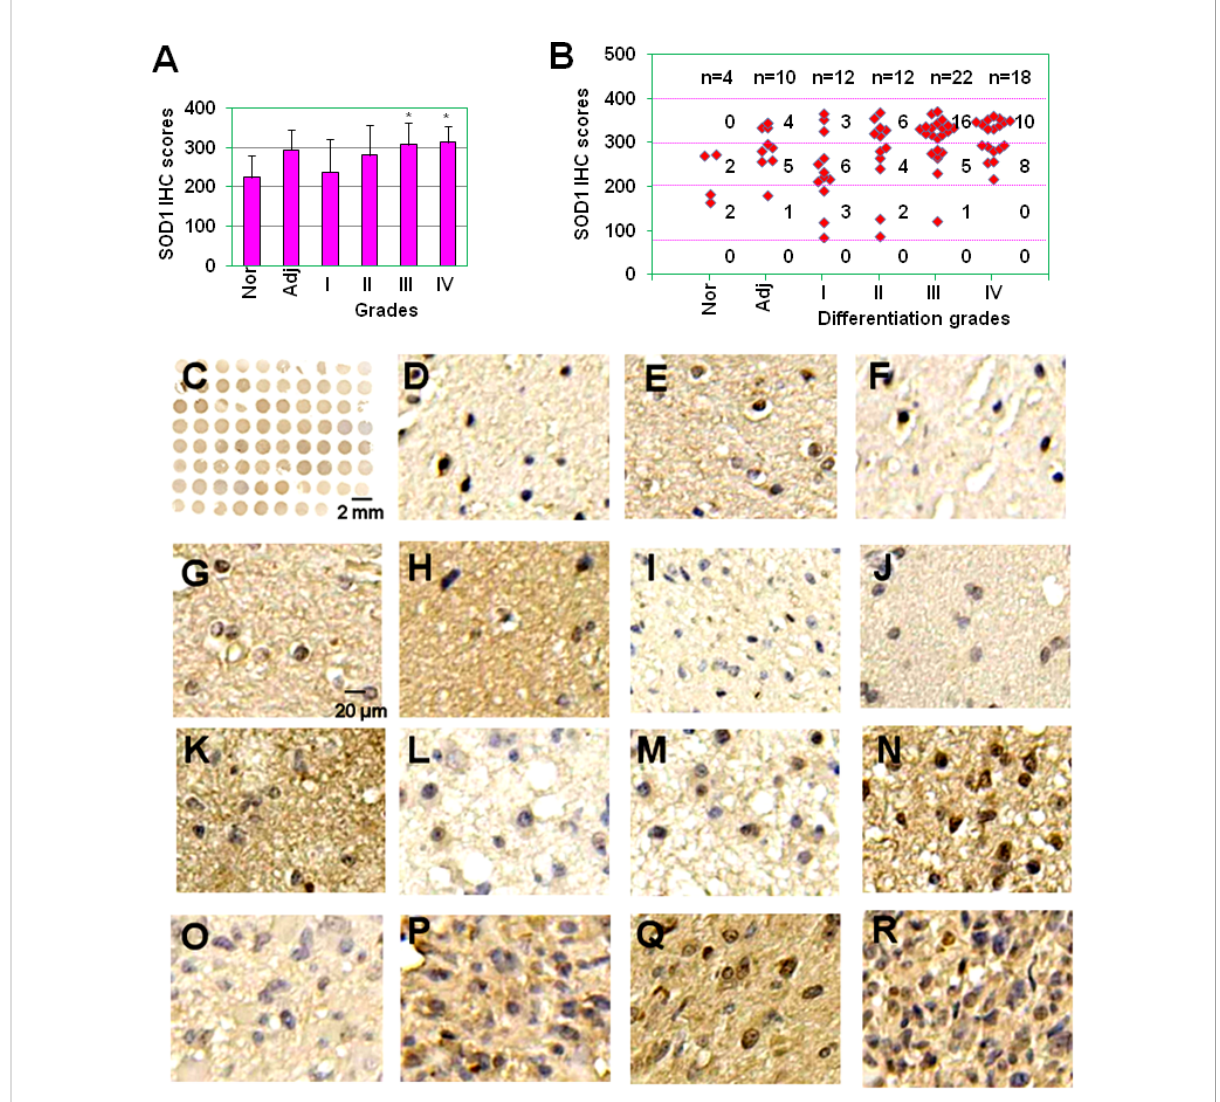
FIGURE 1 The expression of SOD1 in glioma tissues. (A) SOD1 IHC scores of normal brain tissues, tumor adjacent tissues and glioma grade I, II, III and IV tissues. * P < 0.05 compared with the normal brain tissue (Nor) or glioma grade I tissues. (B) Staining intensity of glioma with different histopathological types. Staining intensity was scored using a four-tier scale and de fi ned as follows: negative staining (0-80); weak staining (80- 200); moderate staining (200-300); strong staining (300-400). Nor, normal brain tissue; Adj, glioma adjacent tissues; I, well differentiated glioma; II, moderately differentiated glioma; III, poorly differentiated glioma; and IV, non-differentiated glioma. (C) SOD1 IHC staining for full glioma microarray. (D-E) Representative SOD1 weak (D) , moderate staining (E) in normal brain tissues. (F-H) Representative SOD1 weak (F) , moderate (G) , strong staining (H) in glioma adjacent tissues. (I-K) Representative SOD1 weak (I) , moderate (J) , strong staining (K) in glioma grade I tissues. (L, M) Representative SOD1 weak (L) , moderate (M) , strong staining (N) in glioma grade II tissues. (O-Q) Representative SOD1 weak (O) , moderate (P) , strong staining (Q) in glioma grade III tissues. (R) Representative SOD1 strong staining in glioma grade IV